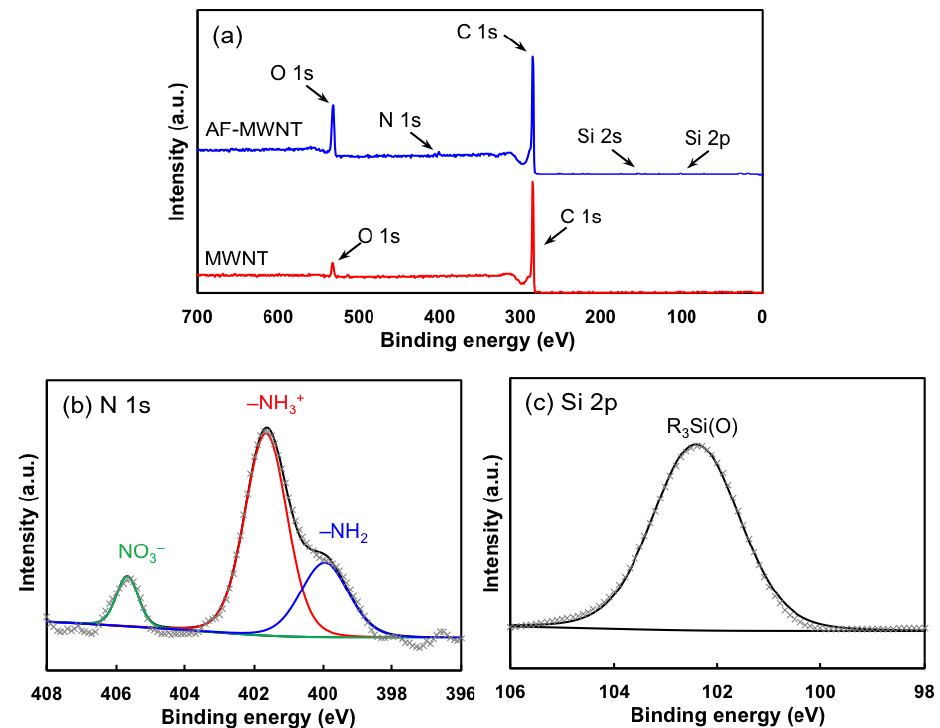
Figure 3. ( a ) X-ray photoelectron spectroscopy (XPS) survey spectra of MWNT and AF-MWNT. The spectrum of AF-MWNT is offset by 50%. ( b ) Spectral decomposition of the N 1s region of AF-MWNT. ( c ) Spectral decomposition of the Si 2p region of AF-MWNT. The black solid lines in ( b , c ) are the fitted envelopes and the gray markers are the spectroscopic data.